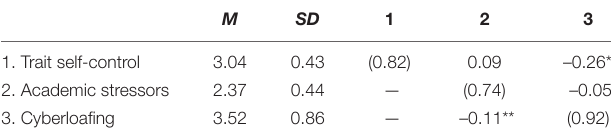
TABLE 1 | Descriptive statistics of and correlations between study